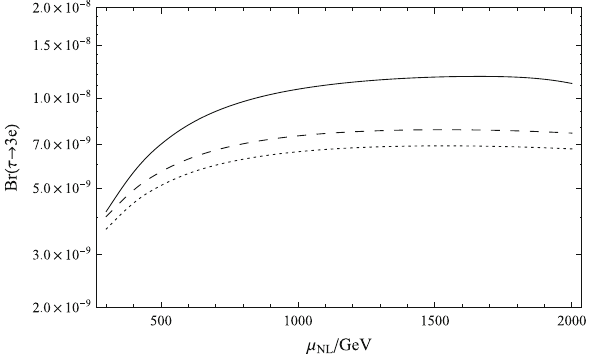
Fig. 17 With tan β NL = 1 . 5 ( 1 . 7 , 1 . 9 ) , the branching ratios of τ → 3 e versus parameter μ NL are plotted by the dotted, dashed and solid lines